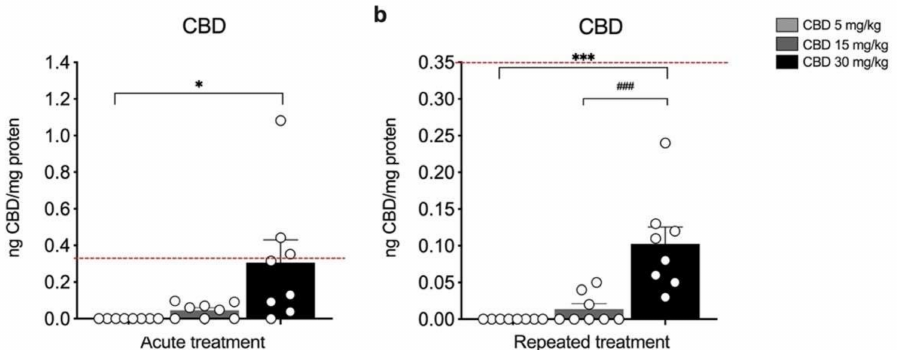
Figure 2. Concentration of CBD in the medial prefrontal cortex (mPFC) of rats treated with a single ( a ) or repeated ( b ) CBD administration at the dose of 5 mg/kg, 15 mg/kg, or 30 mg/kg and killed respectively one ( a ) and twenty-four hours ( b ) after the last treatment. Bar graphs represent the mean ± SEM from eight independent determinations for each experimental group. Red dashed line in panel a indicates the y axis limit (0.35) of the bar chart represented in panel b. Ordinary one-way ANOVA followed by Tukey’s multiple comparisons test, or Kruskal − Wallis one-way ANOVA for ranks followed by Dunn’s multiple comparisons test for non-normally distributed data. * p < 0.05, *** p < 0.001 vs. 5 mg/kg, ### p < 0.001 vs. 15 mg/kg. CBD 5 mg/kg n = 8 CBD 15 mg/kg n = 8, CBD 30 mg/kg n =